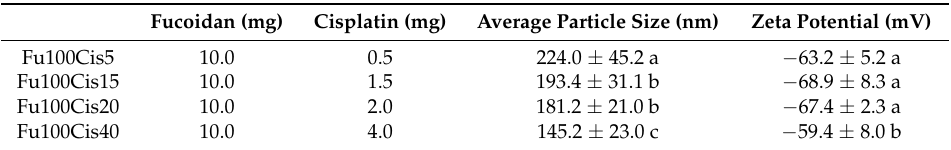
Table 4. Size and zeta potential of fucoidan-cisplatin nanoparticles by 10 mg fucoidan mixing with different weights of cisplatin. Fucoidan (mg) Cisplatin (mg) Average Particle Size (nm) Zeta Potential (mV)